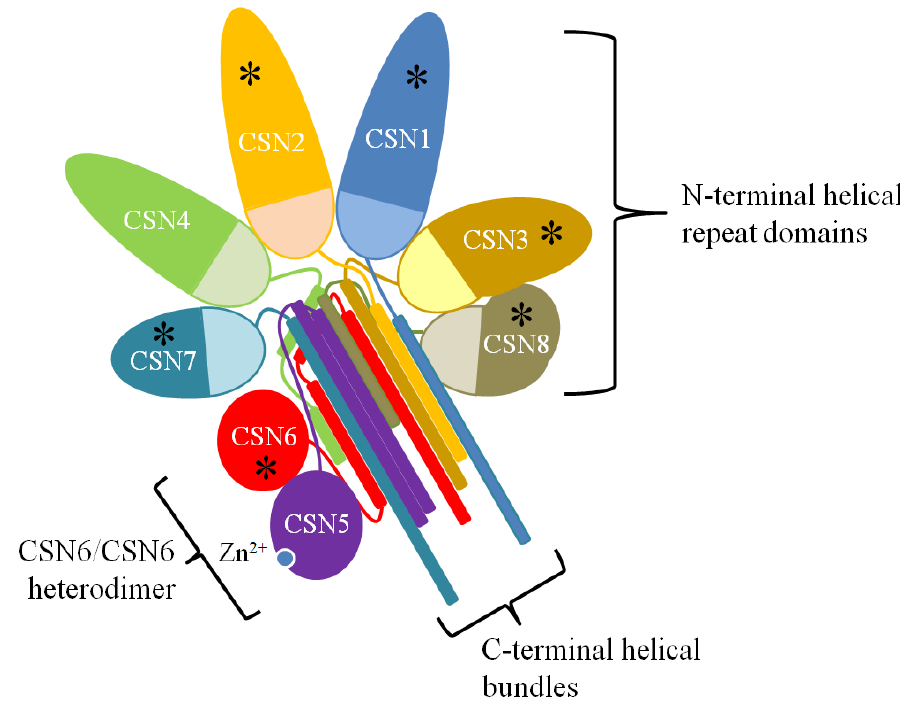
Figure 1. The CSN Structure. A two-dimensional schematic representation of the three-dimensional structure of the CSN as determined by Lingaraju et al [34]. The N-terminal repeat domains radiate out from the winged-helix domains of the PCI ring (lightly shaded half-circles). The C-terminal helical regions form a helical bundle that stabilizes the complex. The MPN domains of CSN5 and CSN6 rest on the helical bundle. Subunits reported as phosphorylation targets are marked with an asterisk